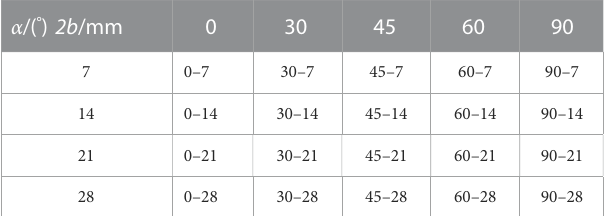
TABLE 1 Test plan and specimens ’